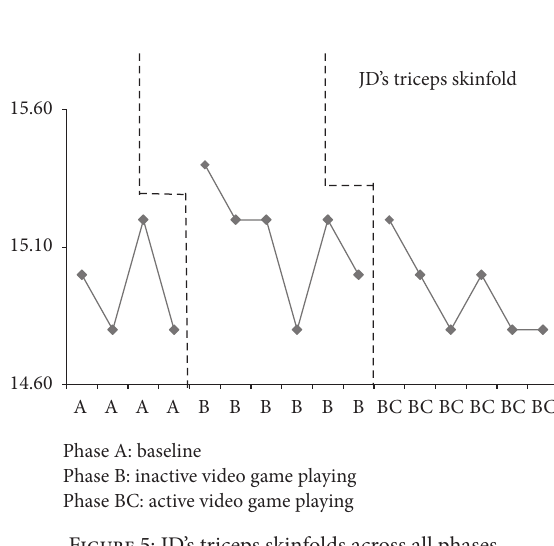
Figure 5: JD’s triceps skinfolds across all